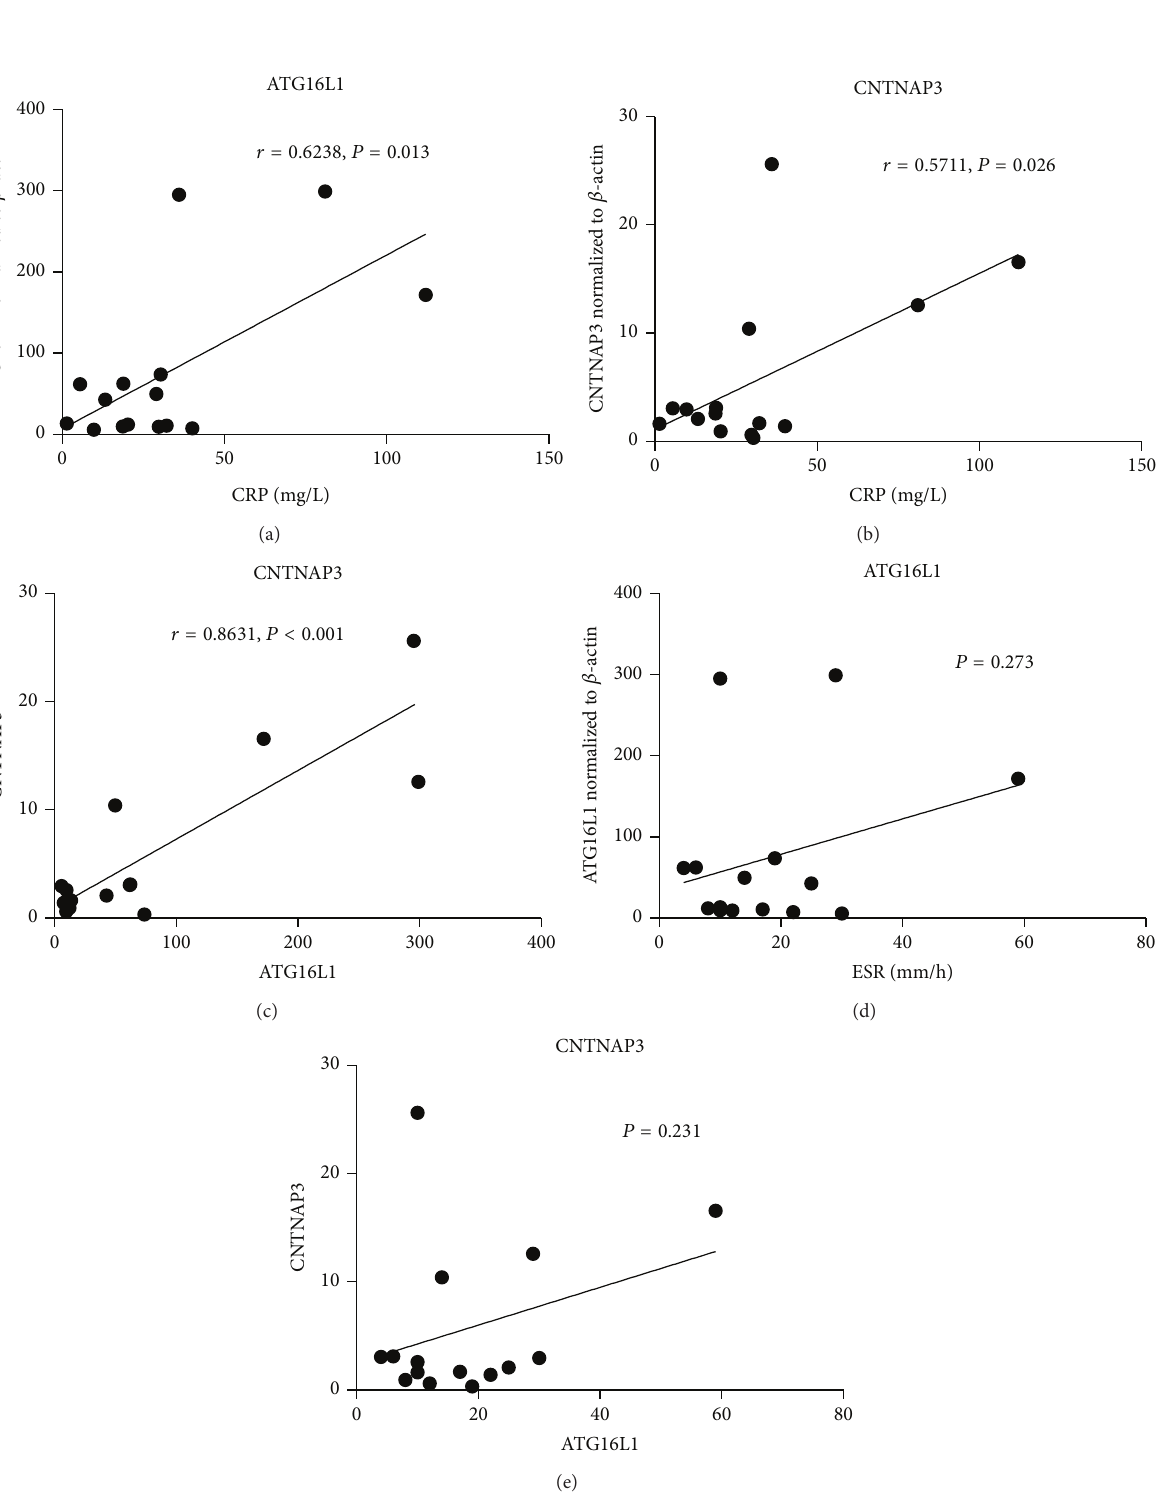
Figure 2: The relationships between CNTNAP3, ATG16L1, and some serum markers. Spearman correlation analysis indicated ATG16L1 mRNA expressions were significantly associated with the serum levels of CRP ( 𝑟 = 0.6238 and 𝑃 = 0.013 ) (a). CNTNAP3 was also showed significance correlated with CRP ( 𝑟 = 0.5711 and 𝑃 = 0.026 ) (b). CNTNAP3 changes positively correlated with the ATG16L1 level ( 𝑟 = 0.8631 and 𝑃 < 0.001 ) (c). Unfortunately, it was found that neither CNTNAP3 ( 𝑃 = 0.273 ) nor ATG16L1 ( 𝑃 = 0.231 ) was significantly correlated with ESR (d,